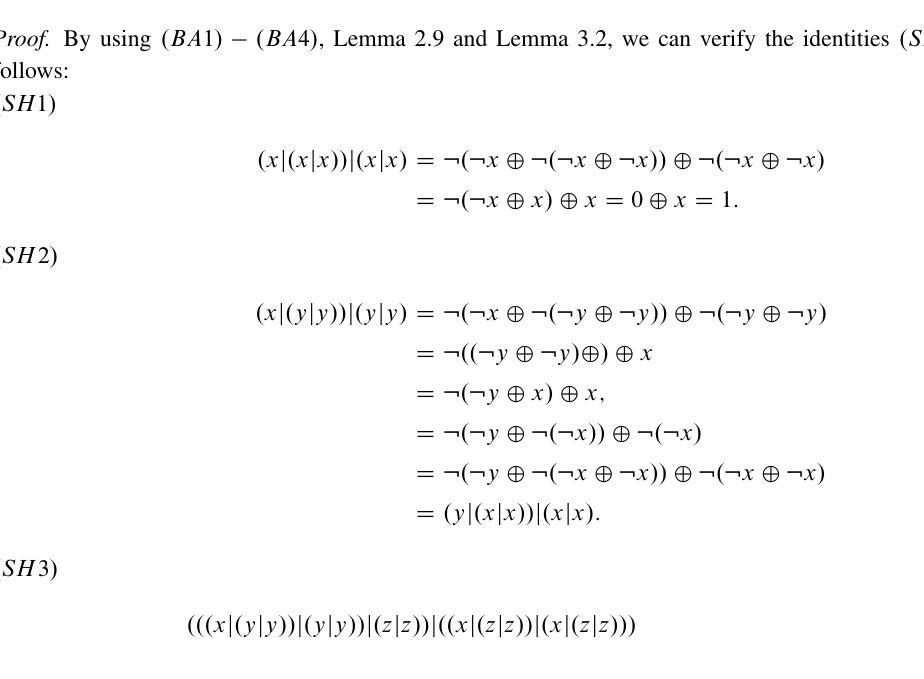
The model j A satisfies .SH1/ and .SH2/ , but not .SH3/ . When we choose x D 0 and y D z D 1 , we